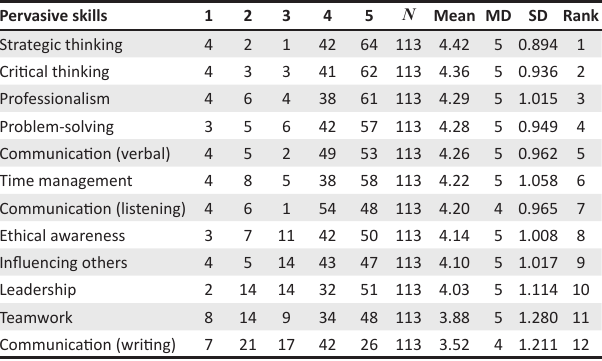
TABLE 1: Development of pervasive skills through the board game (Commerce 100). Pervasive